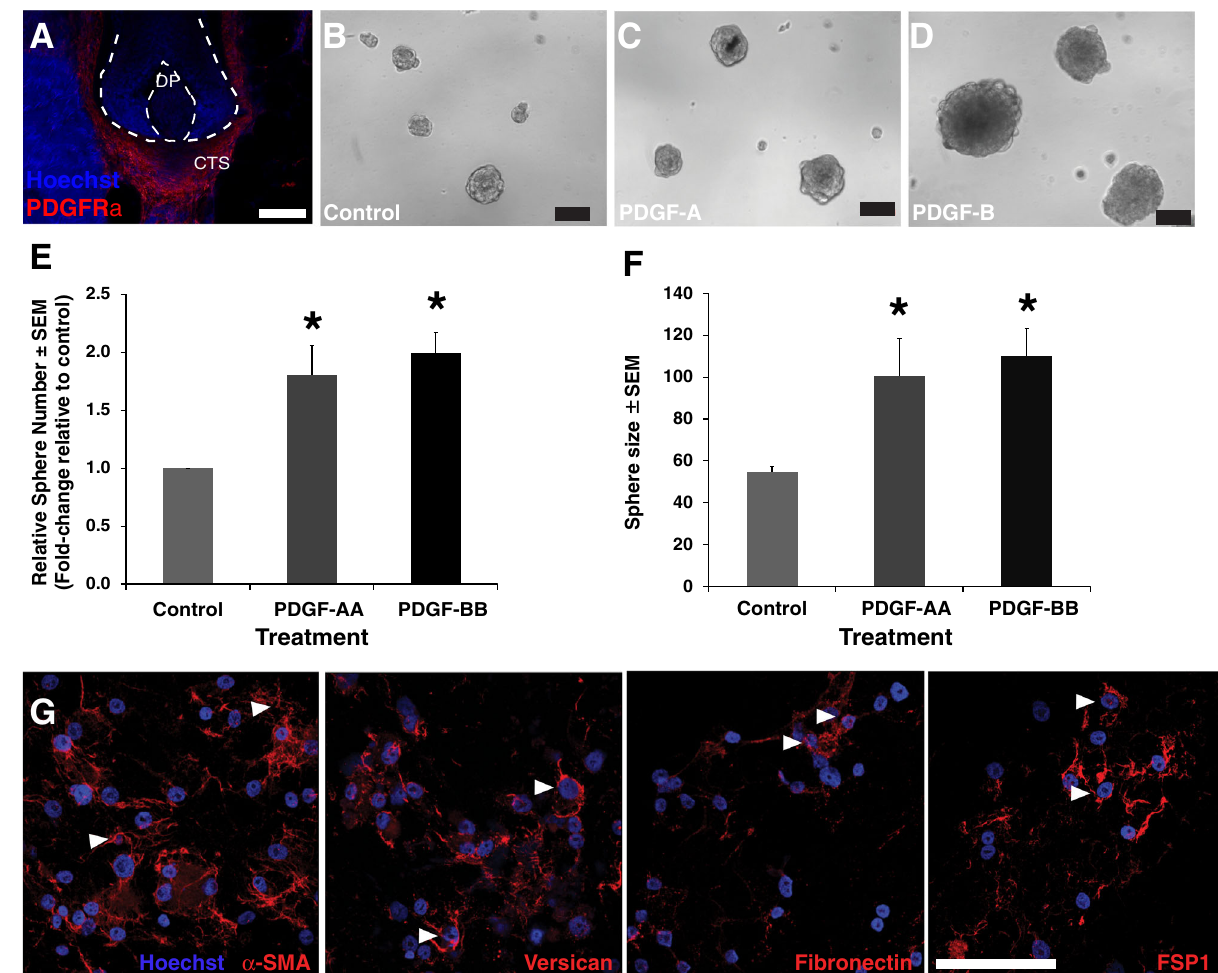
Fig. 6 PDGF enhances adult human SKPs proliferation. a Image of an adult human scalp HF immunostained for PDGFR α . Note the absence of reactivity of the DP, but robust expression in the CTS compartment. Both the DP and the HF are outlined by dashed lines. b Human SKPs cultured in the absence of PDGF ligand or treated with 50 ng/ml c hPDGF-AA or d hPDGF-BB. e Fold-change in spherical colony number relative to control, formed after culturing human SKPs in the absence or presence of PDGF-AA or PDGF-BB. f Colony size (diameter) of the spheres formed in the presence of PDGF-AA or PDGF-BB vs. control. Data were collected from a total of four adult ( > 27 years of age) human samples. Data are mean ± SEM. Asterisks denote p < 0.05; Kruskal – Wallis, followed by a Mann – Whitney U test. See also Supplemental Information for immuno fl uorescence details. Scale bars represent 100